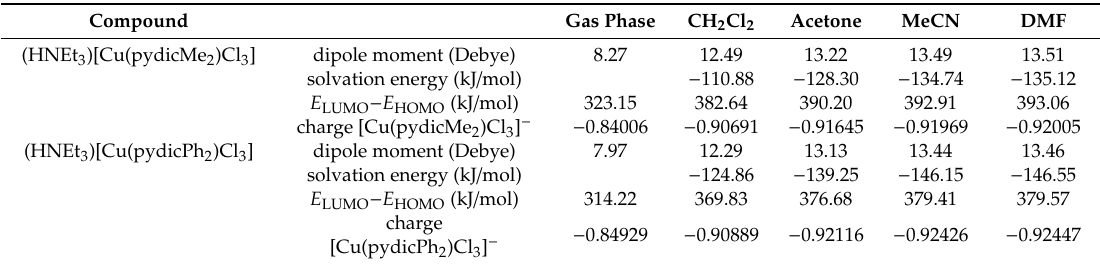
Table 1. DFT-calculated dipole moments and solvation energies of (HNEt 3 )[Cu(pydicMe 2 )Cl 3 ] and (HNEt 3 )[Cu(pydicPh 2 )Cl 3 ] in the gas phase and solvent media.